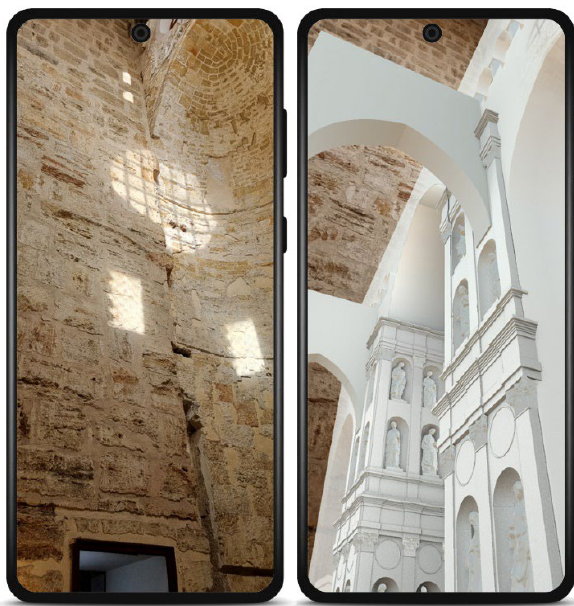
Figure 11 . AR visualization of the ‘Tribuna’ from the southern ancient apse, using the Persistent Cloud Anchors technology of Google ARCore.